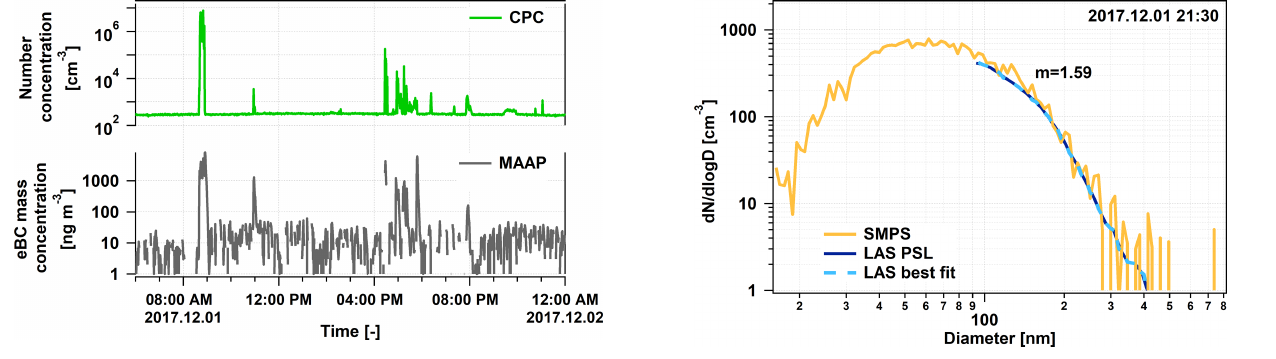
Figure 8. A successful RI fit from 1 December 2017 with high con- tamination